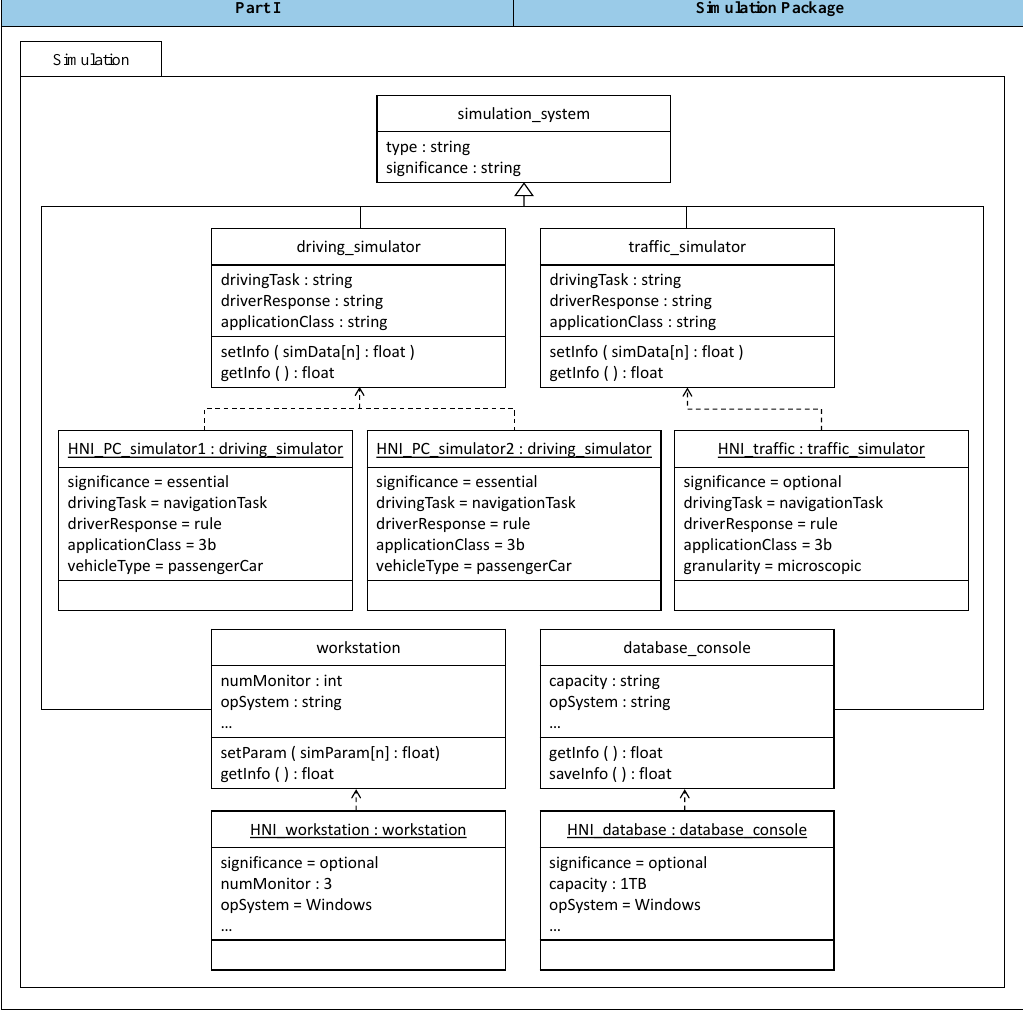
Figure 20. UML class diagram of the selected communication system components—package 2.